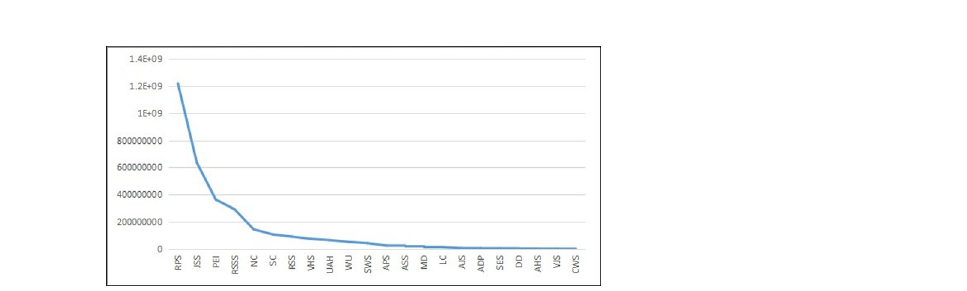
Fig 5. The Distribution curve of enrolled student numbers for different education categories in China from 2003– 2014 (Unit: Quantity). NC is Undergraduate Courses. SC is Junior College Education. UAH is Undergraduates in Adult HEIs. WU is Network Undergraduates. MD is Master’s Degree. ADP is On-the-job Master’s Degree. DD is Doctor’s Degree. Other indexes are the same as above.